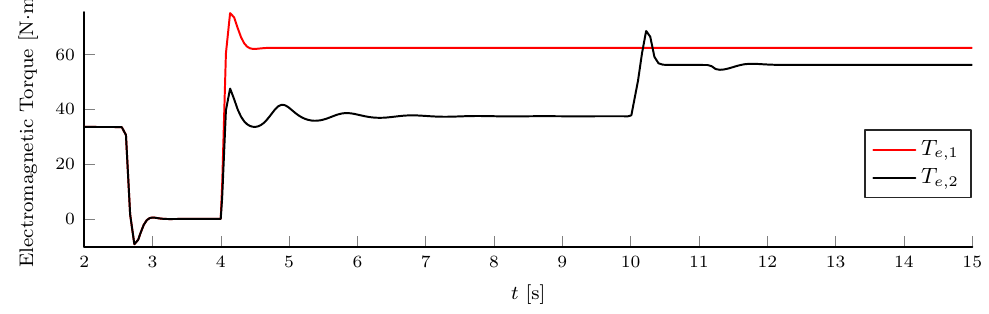
Figure 27. Electromagnetic torque: torque sufficiency study.